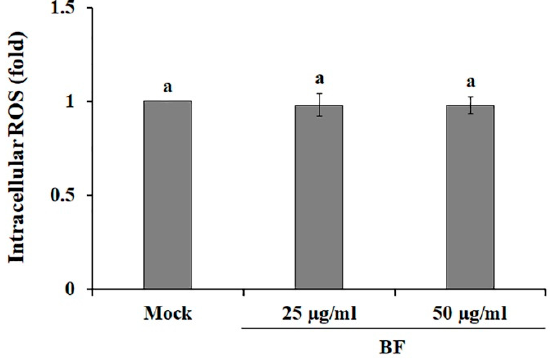
Figure 3. Effects of the BuOH fraction (BF) on reactive oxygen species (ROS) production in SK-MEL-2 cells. ROS level was analyzed using the fluorescent probe DCFH-DA. DMSO treated samples served as mock. Values are reported as the mean ± SE. Values with different letters were found to be significantly different ( p < 0.05).